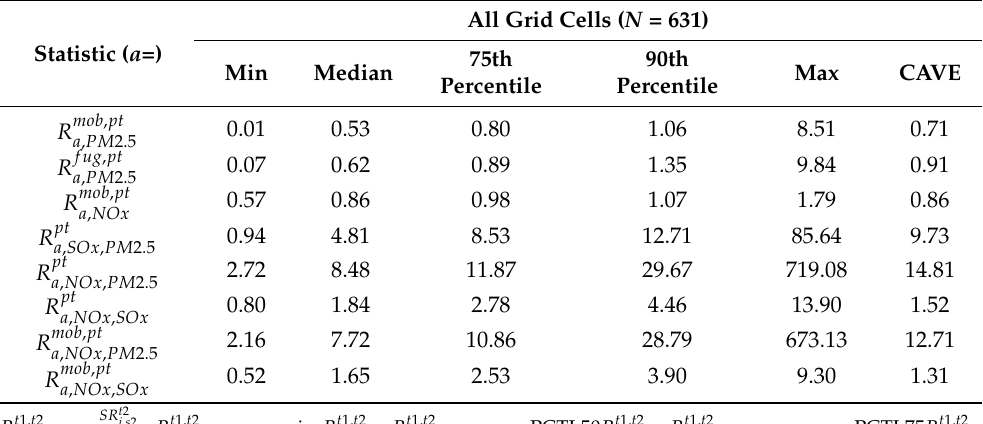
Table 3. Distribution of offset ratios over